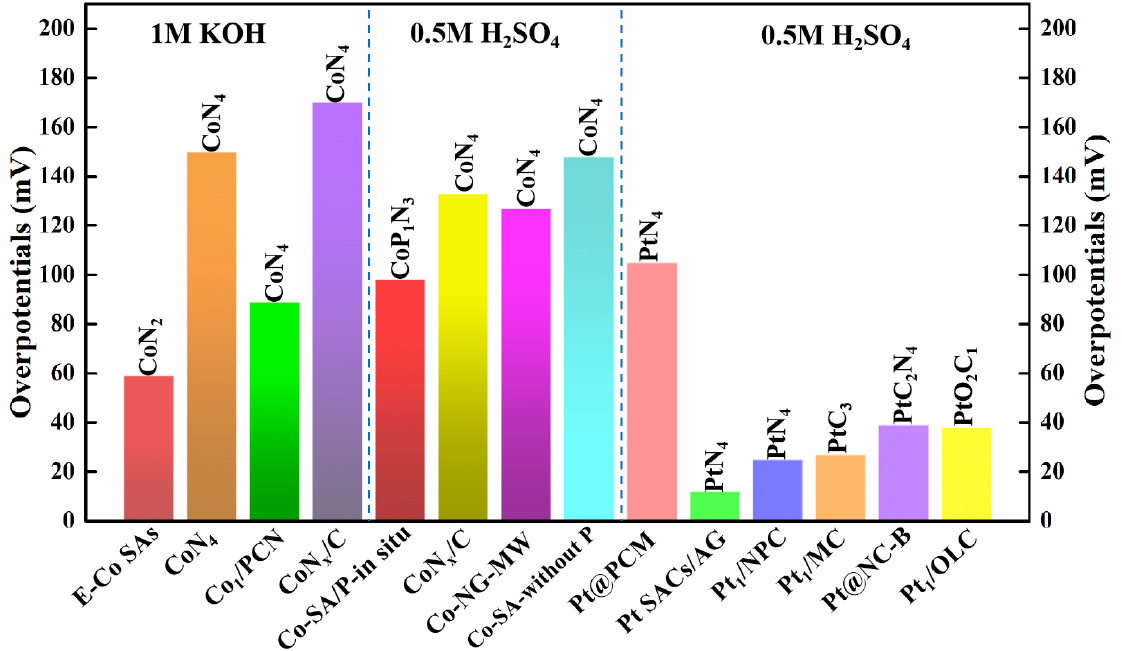
Figure 6. The HER performance overviews of the symmetric/asymmetric coordination